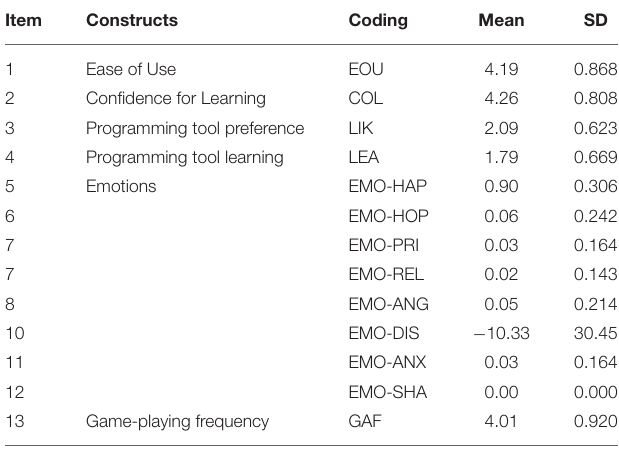
TABLE 5 | Summary of